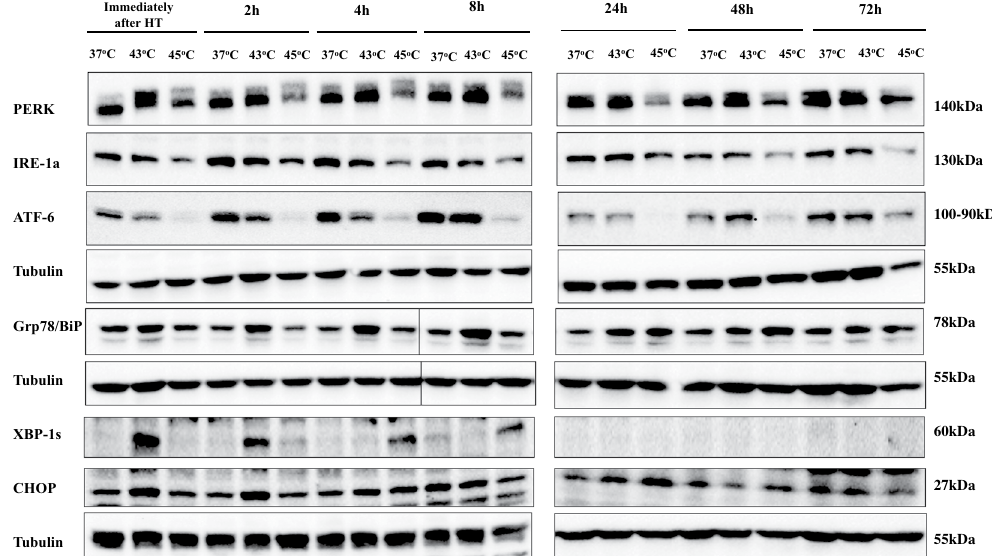
Figure 5. Hyperthermia-induced activation of ER stress response pathwaws in human malignant melanoma (A375) cells. The effect of hyperthermia on protein content of PERK, IRE-1a, ATF-6, GRP78/BiP, XBP-1S and CHOP. Cells were grown overnight at 37 °C followed by exposure to hyperthermia, for 2 h, and then transferred back to 37 °C for the indicated post-exposure incubation times (2–72 h). Cell lysates were prepared and subjected to western blotting. Control cells were kept at 37 °C. β -tubulin was used as loading control. Samples from short and long-post exposure incubation periods following hyperthermia were electrophorized on separate gels. Delineation shows blots cropped from different areas of the same blot or different blots. Full- length blots are provided in Supplementary Material (Fig. 3S). Data shown is representative of at least two independent experiments.